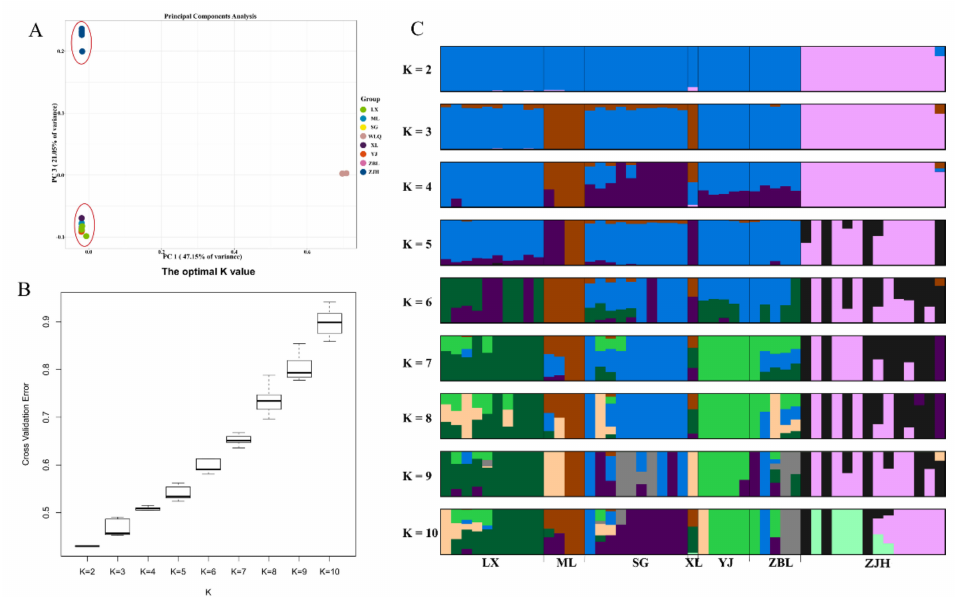
Figure 4. Principal component analysis and the error rate of the S. kolzovi admixture K value. ( A ) Principal component analysis for S. kolzovi based on 303,970 SNPs; ( B ) the error rate of the S. kolzovi admixture K value by cross − validation; ( C ) the clustering results of S. kolzovi . LX, Luoxu; ZBL, Zhubalong; SG, Shigu; XL, Xinlong; YJ, Yajiang; ML, Muli; ZJH, Zongjihe.